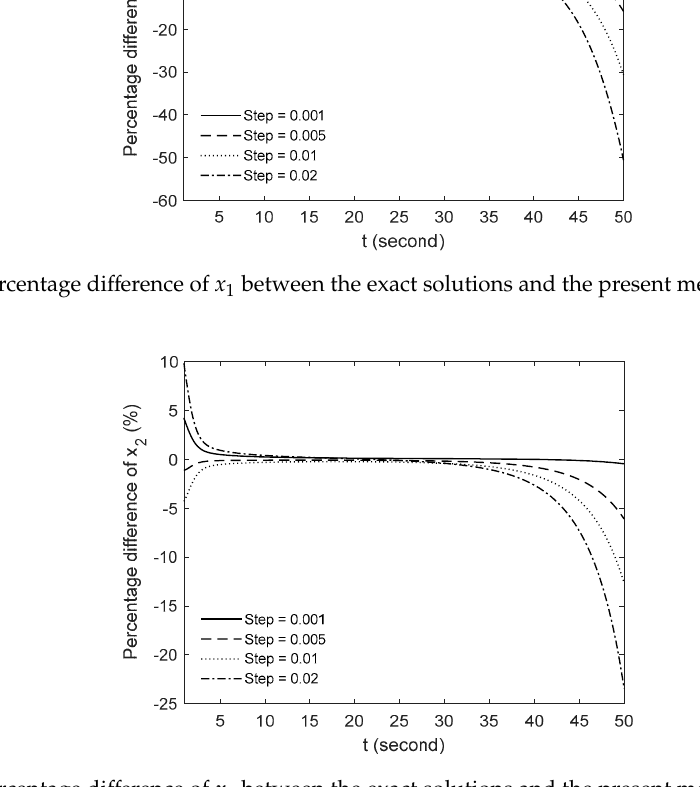
Figure 5. Percentage difference of x 3 between the exact solutions and the present method for different time steps h . 6.2. Comparisons with other Methods Chen et al. [26] proposed a numerical method for solving fractional differential equations by using the Grünwald–Letnikov definition. Wang et al. [20] introduced the sliding mode control method to the FDAEs, and obtained the numerical solution by using the predictor-corrector method [23]. In this section, we aim to study the characteristics of the present method by comparing with the two numerical methods. Consider a numerical example, given by